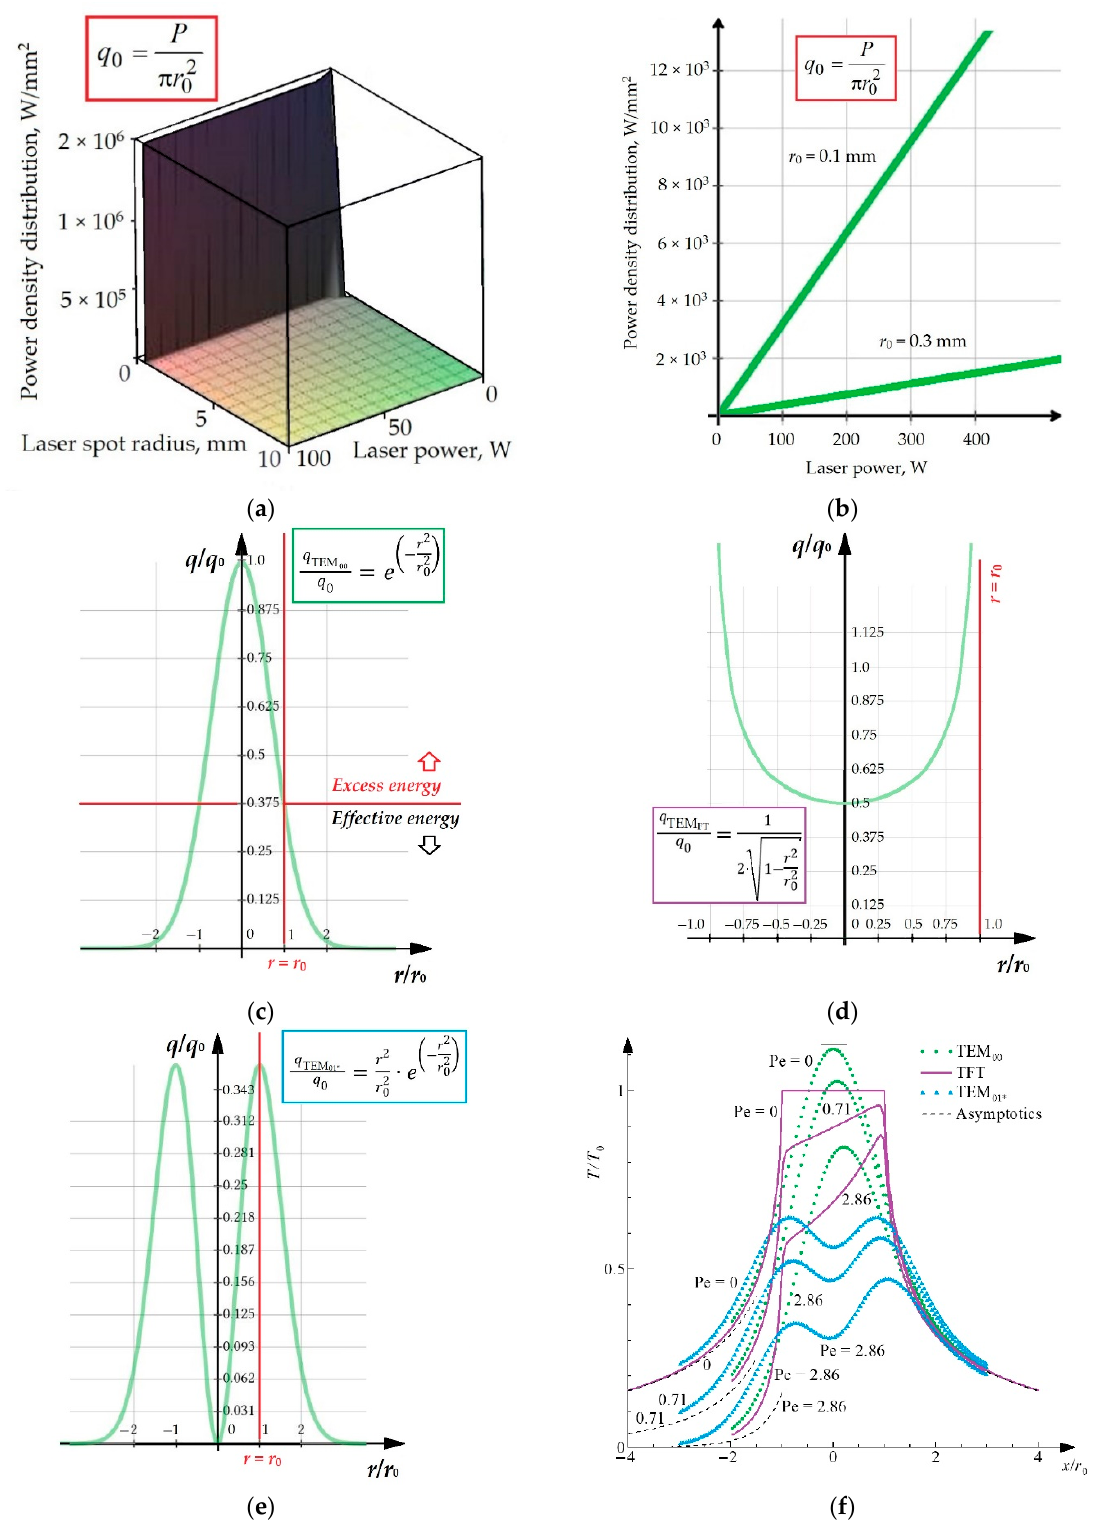
Figure 3. 3D plot of the implicit function q 0 ( a ); implicit function q 0 for various values of r 0 ( b ); normalized implicit function q / q 0 (TEM 00 profile) ( c ); normalized implicit function q / q 0 (TEM FT profile) ( d ); normalized implicit function q / q 0 (TEM 01* profile) ( e ); and temperature distributions along the direction of the scanning speed on the surface, when y = 0, z = 0 ( f ). The beam boundary where r = r 0 is marked red in graphs ( c – e ).